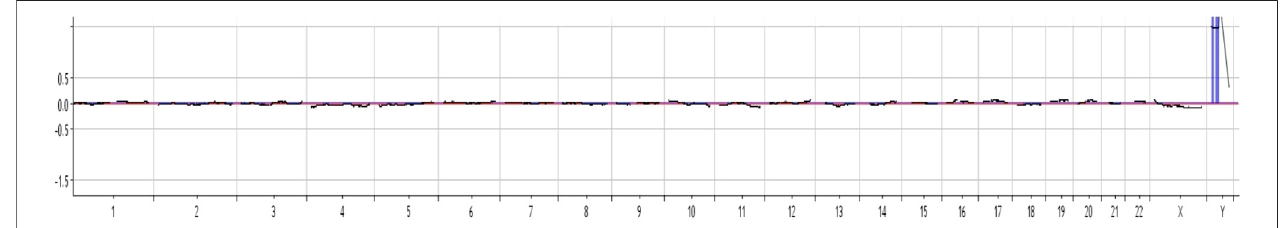
FIGURE 2 | Cell-based NIPT chromosomal microarray of a WGA pool from three fetal cells (GA 10 + 5). The chromosomes (1 – 22,X,Y) are represented on the horizontal axis and the thresholds for gains and losses are indicated by the vertical axis. The sample is matched against reference DNA representing a female karyotype 46,XX. The result shows presence of two X chromosomes and gain of chromosome Y. Hence, the cell-based NIPT result suggests a 47,XXY karyotype.